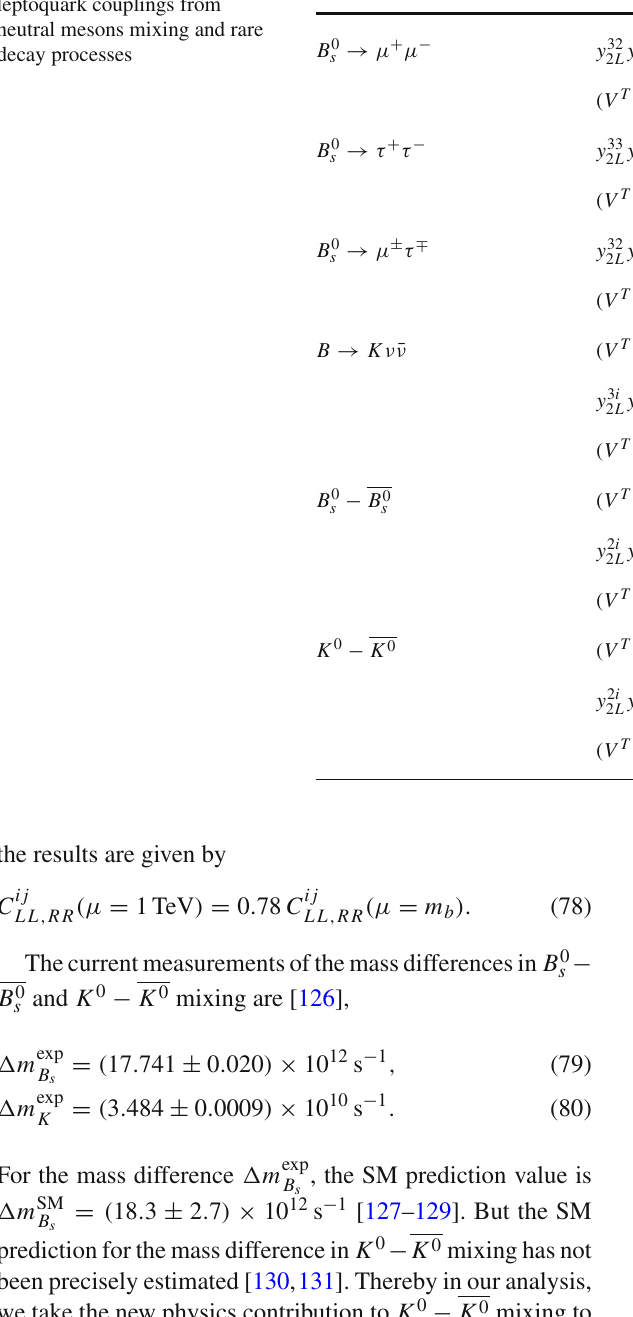
Processes Constraints on the